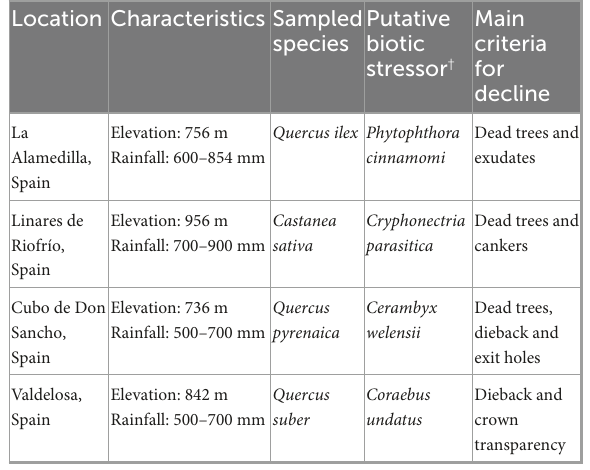
TABLE 1 Description of sampling sites. Location Characteristics Sampled